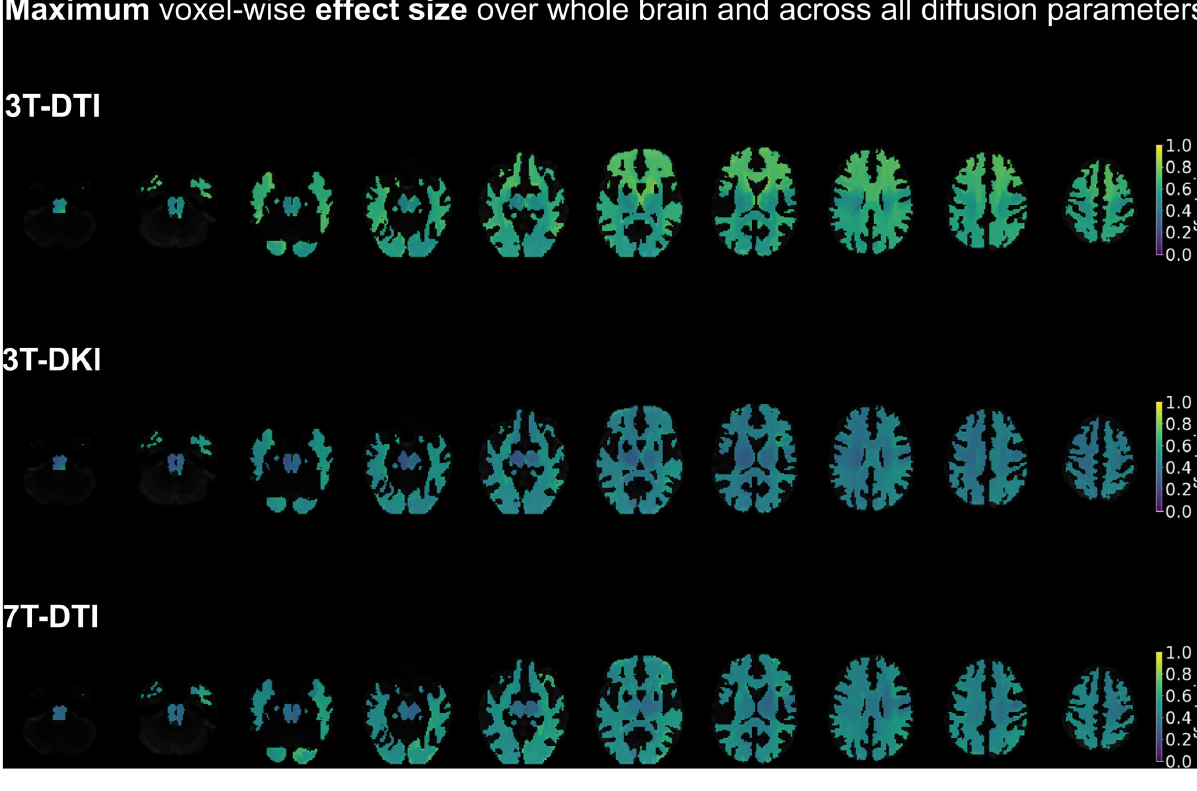
FIGURE 10 | A summary of the spatial distribution of effect sizes over the whole brain, taking the maximum voxel-wise effect sizes across all diffusion tensor and kurtosis parameters (FA, MD, AD, and RD for all three acquisition protocols plus MK, AK, and RK in case of 3T-DKI). Effect sizes in the depicted brains range from 0.0 (deep purple areas) to 1.0 (yellow areas). Overall, 3T-DTI was the protocol with the highest effect sizes among all three acquisition protocols, with more voxels with an effect size exceeding the value 0.54, which was the threshold for significance (turquoise